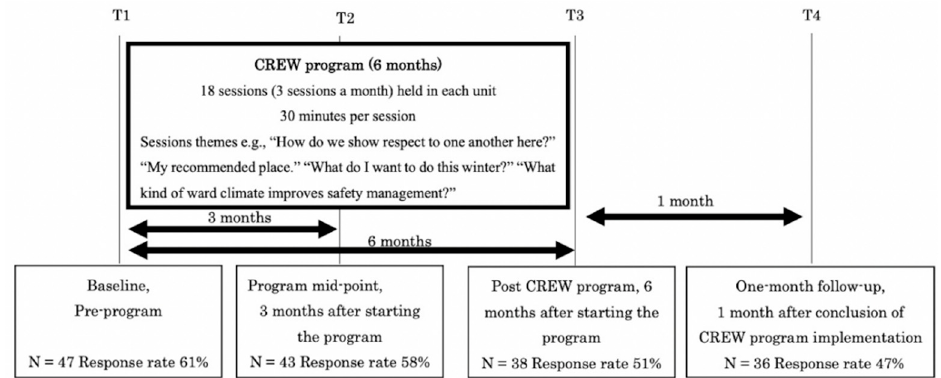
Figure 1. Survey process and CREW process relationships and timeline.